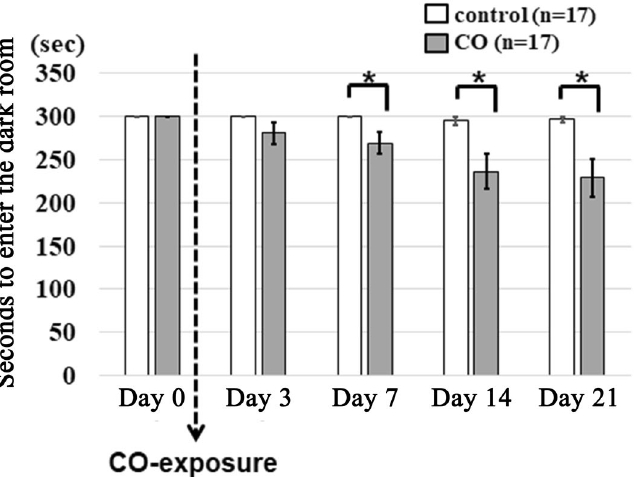
Figure 1. Changes in passive avoidance test latencies. The latencies in the passive avoidance test are significantly shorter in the CO rats than in controls from day 7. * p <